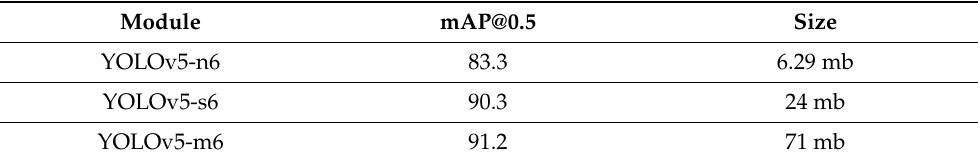
Table 6. Performance of YOLOv5-P6